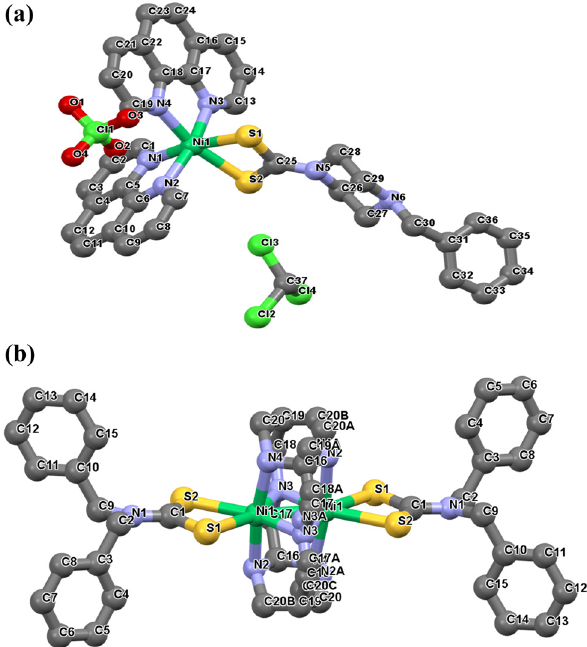
Figure 15: Molecular structure of ( a ) [ Ni ( Bzppzdtc )( phen ) 2 ] ClO 4 .CHCl 3 and ( b ) [ Ni ( Bz 2 dtc ) 2 ( cyclam )] . Redrawn from ref. [ 55 ] , with permission from Elsevier ( Copyright 2020 )